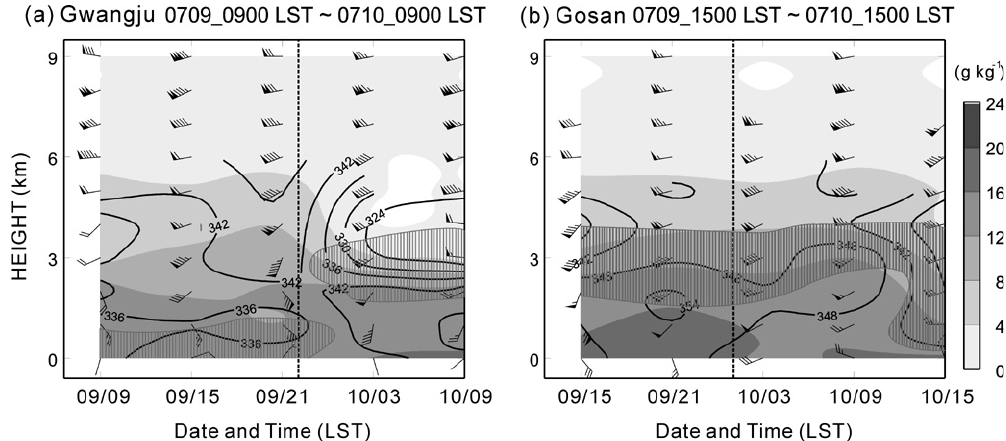
Fig. 9. Time height cross-section of equivalent potential temperature θ e (contoured every 6K), mixing ratio q (gkg − 1 , shaded), and horizontal wind (knot, barbs) of soundings taken at (a) Gwangju and (b) Gosan. The shaded area indicates unstable layer. The dotted line is passage time of the NM α CS and SM β CS, near 22:00LST, 9 July and 01:00LST, 10 July, respectively. For winds, full (half) barbs denote 5ms − 1 (2.5ms − 1 )